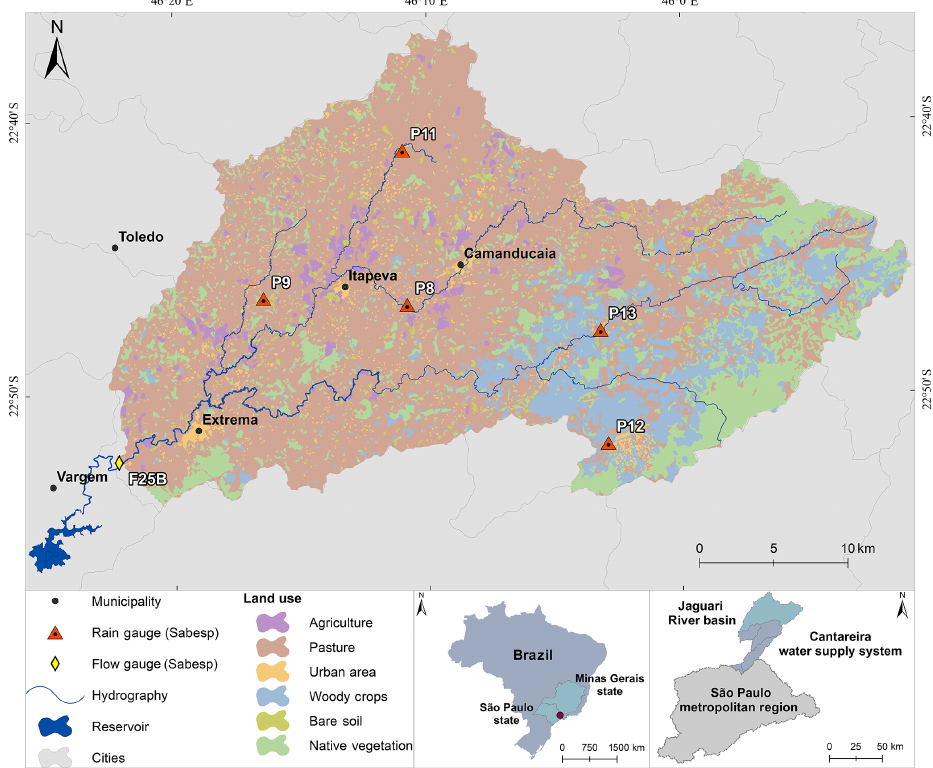
Figure 1. Location and land cover of study area for the reference year of